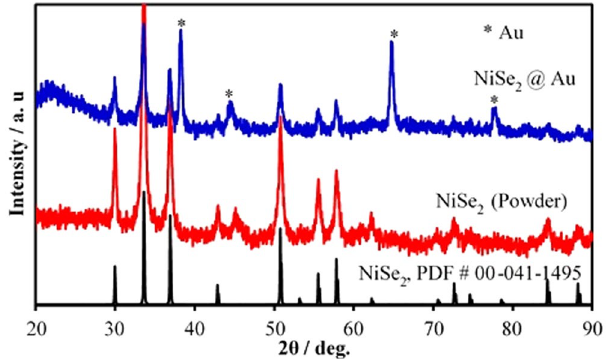
Figure 1. PXRD pattern of electrodeposited NiSe 2 @ Au (blue) and NiSe 2 powder (red) showing the presence of NiSe 2 (PDF # 00-041-1495).